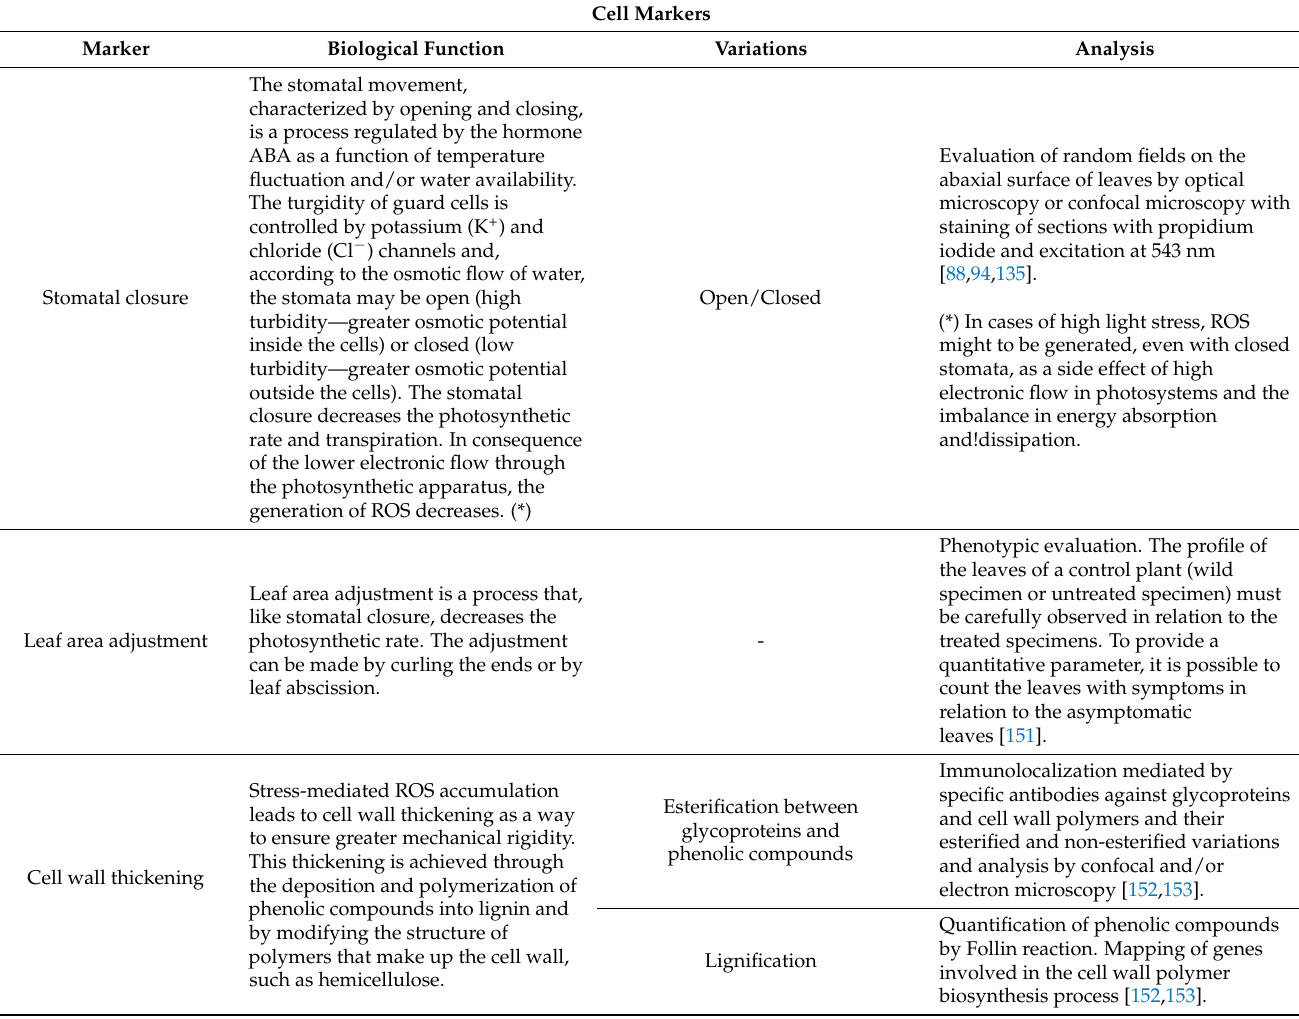
Table 1. Cellular, molecular, physiological and gene markers in the adaptive response of plants to abiotic